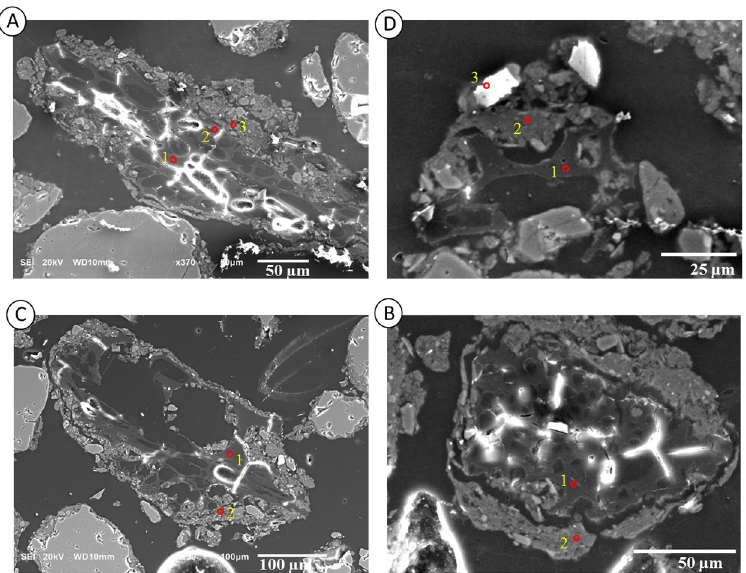
Fig 9. Scanning electron microscopy of particles of charcoal from a soil thin section collected between Layers II and III of the Bibocas II archaeological site. The red points indicate the EDS microanalysis data shown in Table 3. Images A and B show the charcoal particles within a soil microaggregate. Image C shows a clay coating over the charcoal particles. Image D illustrates the quasi-coating formed by clay minerals and nano-charcoal particles, which is suggested by the high content of carbon in the clay